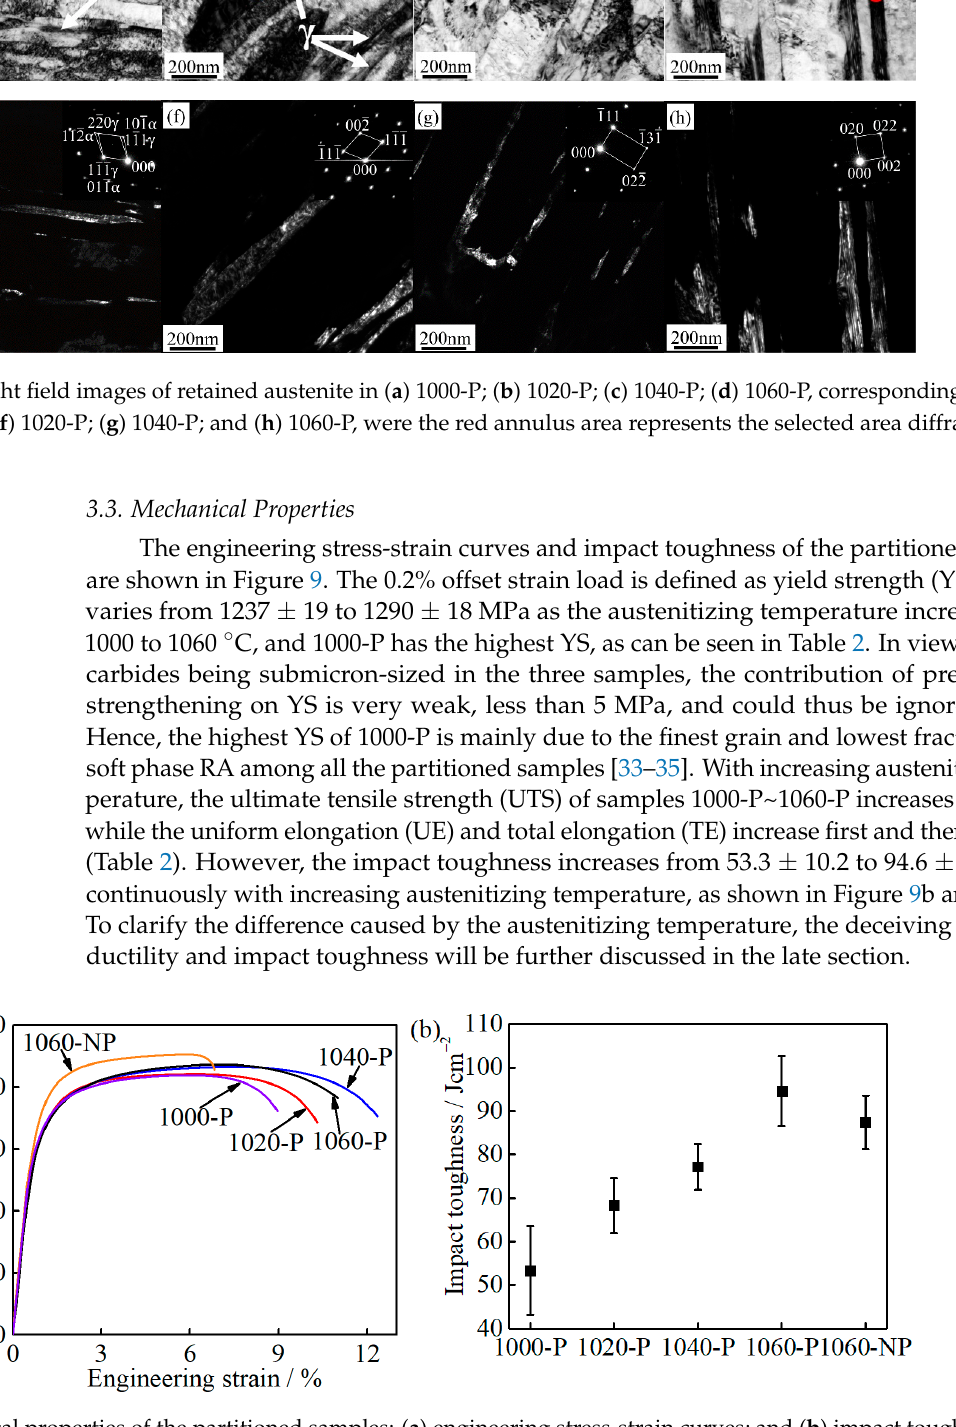
Figure 9. Mechanical properties of the partitioned samples: ( a ) engineering stress-strain curves; and ( b ) impact tough- ness. Table 2. The results of the tensile and impact tests.